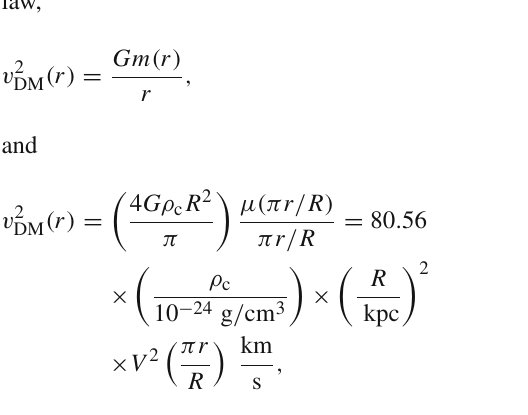
Figure, σ = 0 . 01, γ = 2, (cid:2) = 0 . 3, ρ bc /ρ c = 0 . 2, while θ = 0 . 001 (dotted curve), θ = 0 . 002 (short dashed curve), θ = 0 . 003 (dashed curve), and θ = 0 . 004 (long dashed curve), respectively. In both Fig- ures the solid curve corresponds to the ideal non-rotating condensate dark matter halo, with θ = 0, γ = 0, (cid:2) = 0, ρ bc = 0, and σ = 0